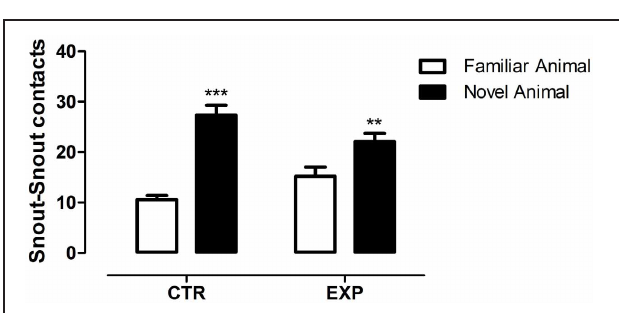
FIGURE 4 | Number of snout-snout contacts is shown as mean ± standard error. Control group (CTR), n = 14 and Experimental group (EXP), n = 16. EXP exhibited less preference for the social novelty than did CTR. ∗∗ p < 0 . 01, ∗∗∗ p < 0 . 0001. in EXP comparatively to CTR ( t = 6 . 26, §§§ p < 0 . 001), and